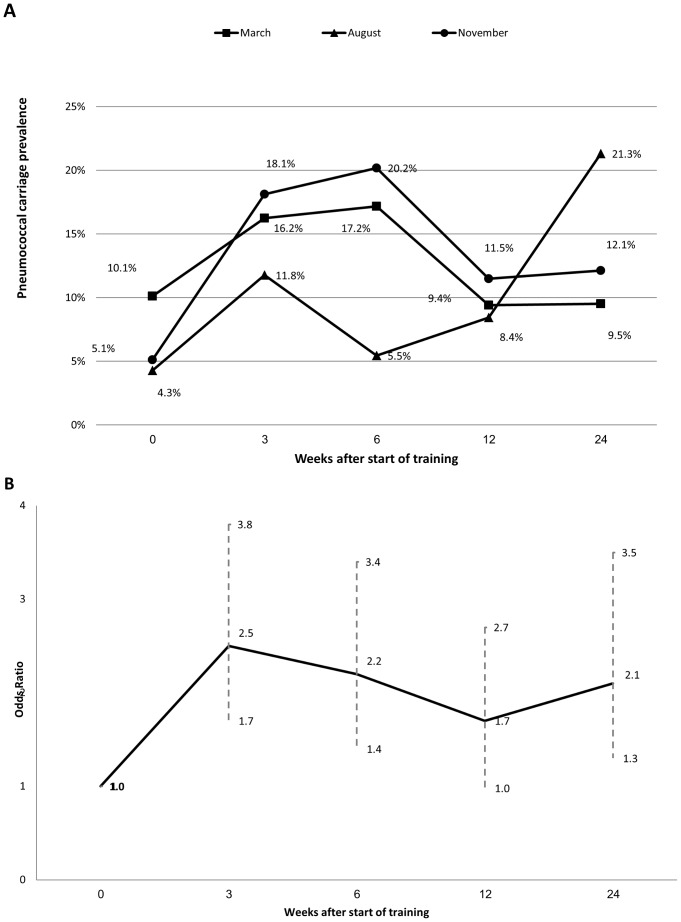
A. Pneumococcal carriage prevalence by cohort and weeks since start of training. B. Odds ratio and 95% confidence interval for pneumococcal carriage prevalence during training compared to first visit, adjusted for season and frequency of sharing drinking glass.